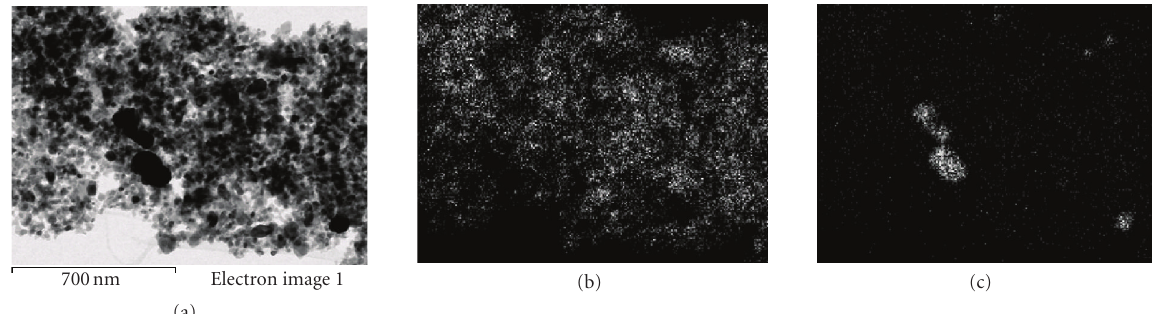
Figure 13: Electron microscopy analysis of 0.2 Ag-TiO 2 photocatalyst particles before the DCA photodegradation reaction. (a) STEM image of particles, (b) corresponding Ti X-ray map, and (c) corresponding Ag X-ray map.